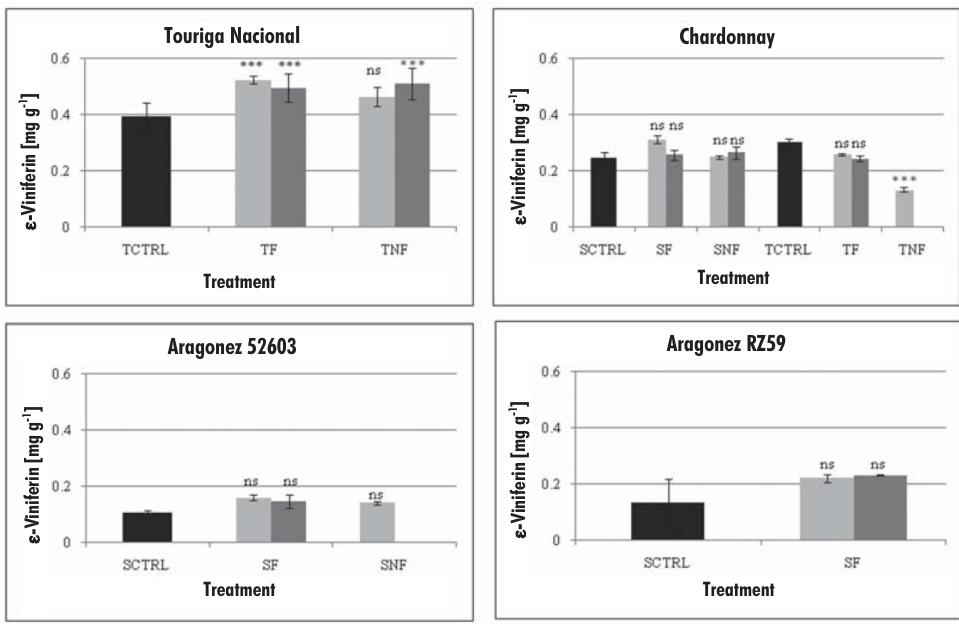
Fig. 2. ε -Viniferin content in healthy and infected plants, from cv. Touriga Nacional, cv. Chardonnay, cv. Aragonez (52603) and cv. Aragonez (RZ59). Different tissue types are represented with infected plants: colonised trunk tissue (TF), uncolonised trunk tissue (TNF), colonised shoot tissue (SF) and uncolonised shoot tissue (SNF). Error bars represent standard deviation (n=4). Level of statistical signi fi cance is also indicated as *, P <0.05; **( P <0.01); ***, P <0.001; ns, non-signi fi cant. Control ( ¢ ), PH9 ( ¢ ), PH13 ( ¢ ). For control treatments, TCTRL refers to trunk control and SCTRL refers to shoot